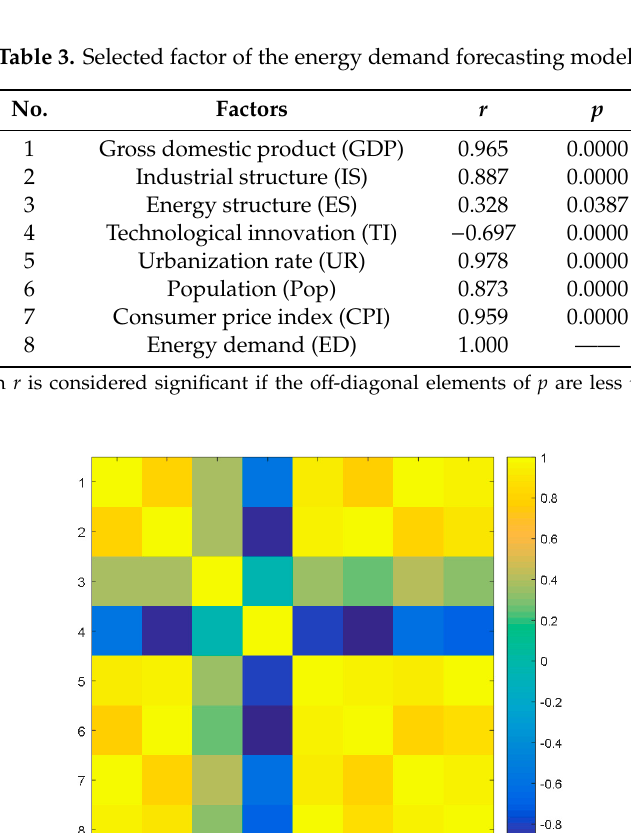
Table 3. Selected factor of the energy demand forecasting model.